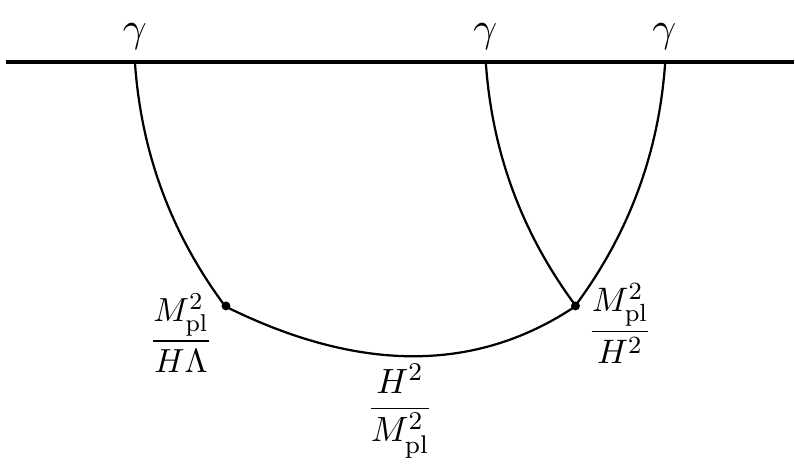
Figure 3. Three-point exchange diagram in the parity-odd sector of the EFT of